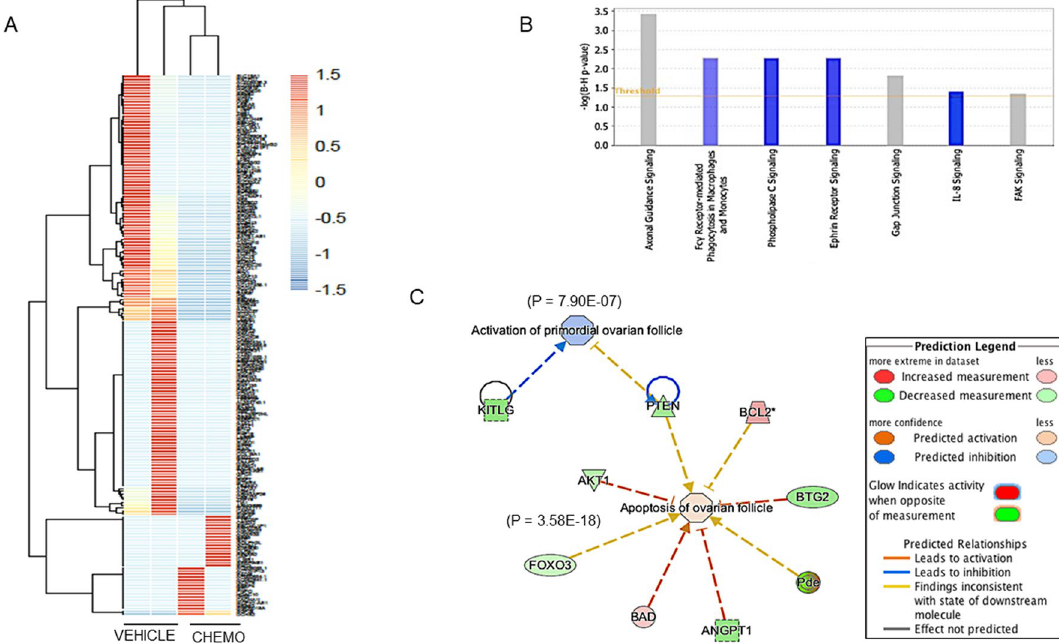
Figure 2. Individual-oocyte RNA-Sequencing and Ingenuity Pathway Analysis (IPA) Results. ( A ) Heat map of genes that are significantly altered 12 h after cyclophosphamide exposure compared to the vehicle treatment. The pheatmap package in R software was used for visualization. ( B ) Major pathways that were found to be significantly altered after chemotherapy exposure. The over-represented pathways are ranked according to the calculated Benjamini–Hochberg FDR, p < 0.05. ( C ) IPA was utilized to find the overlap between the differentially expressed genes in our study and those genes in the IPA knowledge base associated with the functions